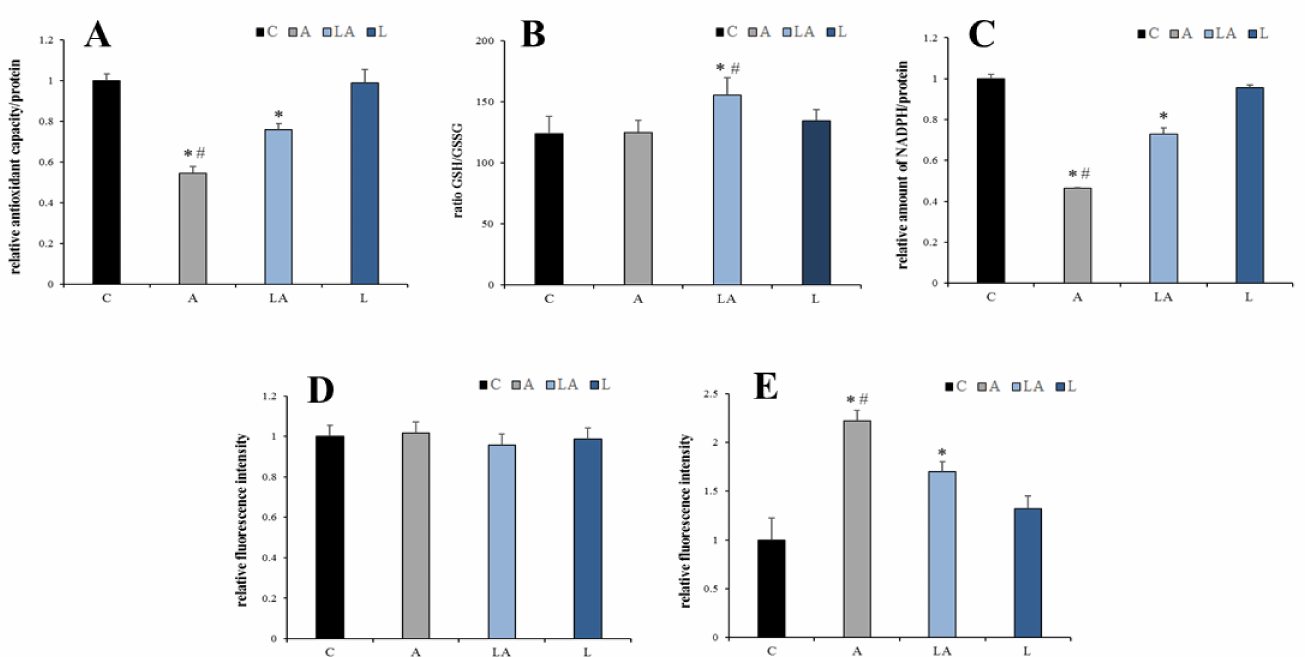
Figure 5. The effect of lactic acidosis on redox homeostasis of cancer cells. PaTu-8902 cells were treated with the ex- perimental media for 72 h and ( A ) relative antioxidant capacity, ( B ) ratio of reduced (GSH) to oxidized (GSSG) glu- tathione in the cells, ( C ) relative concentration of NADPH, ( D ) oxidation of dihydroethidium, and ( E ) oxidation of 2 (cid:48) ,7 (cid:48) -dichlorodihydrofluorescein measured as a relative fluorescence were determined. C, control; A, acidosis; LA, lactic acidosis; L, high lactate (* p < 0.05 compared to C, # p < 0.05 when comparing A and